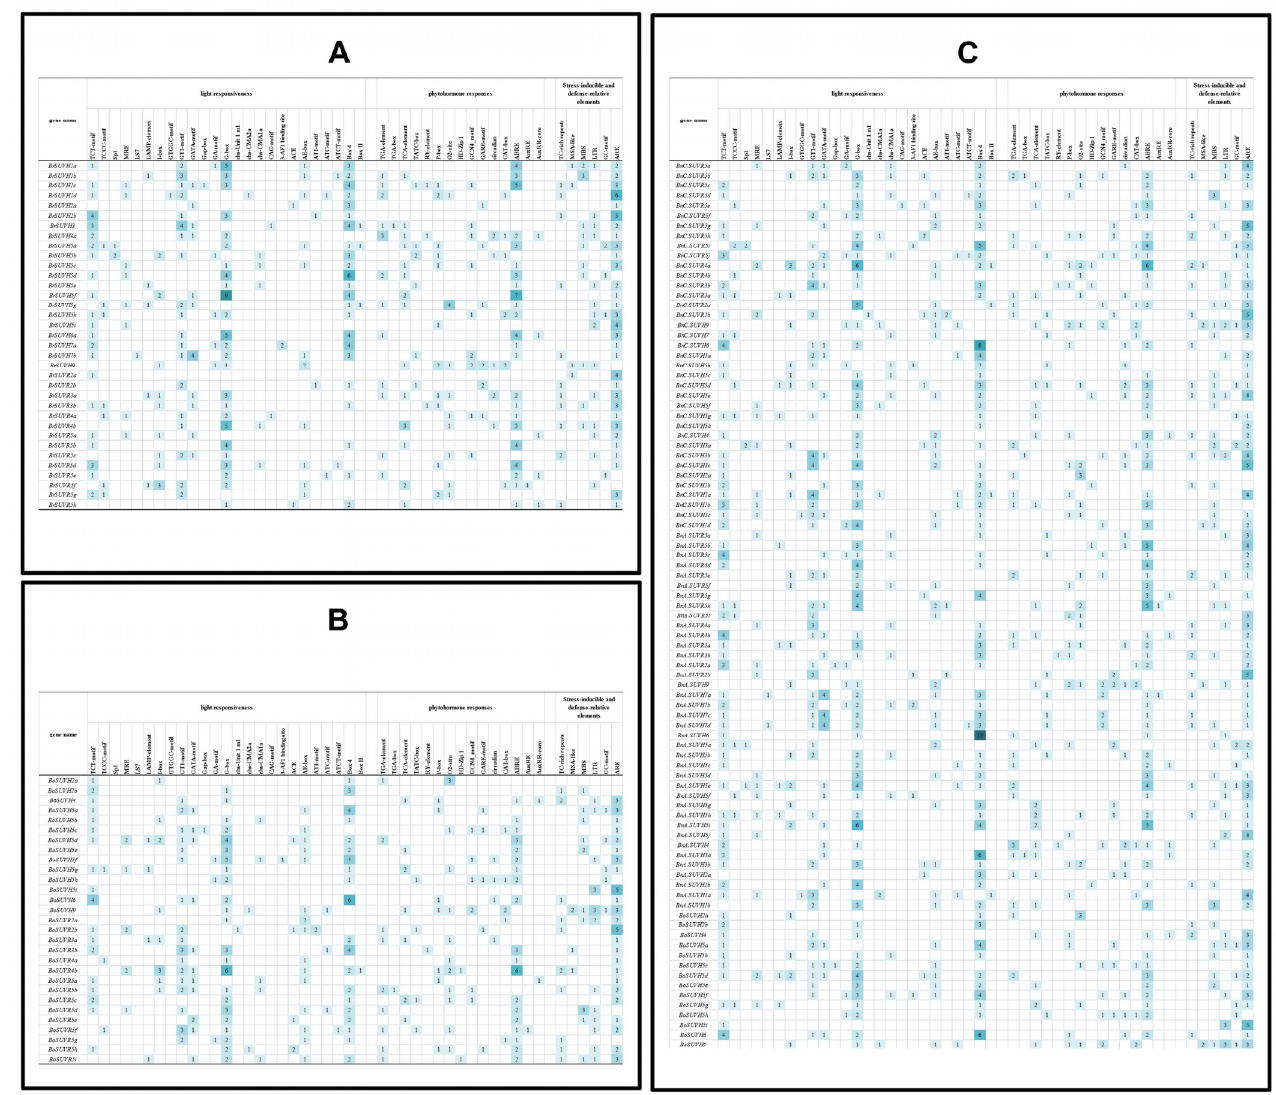
Figure 8. Number of elements responsive to stresses and hormones in the promoter regions of BrSUV ( A ), BoSUV ( B ) and BnSUV ( C ) genes.